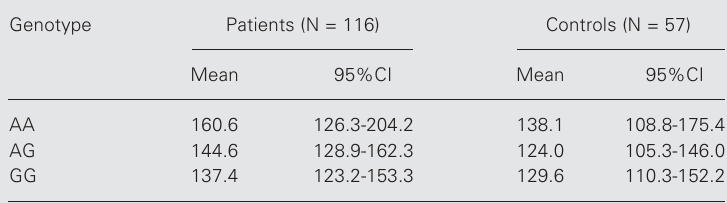
Table 4. Plasma von Willebrand factor levels according to -1185A/G genotype.